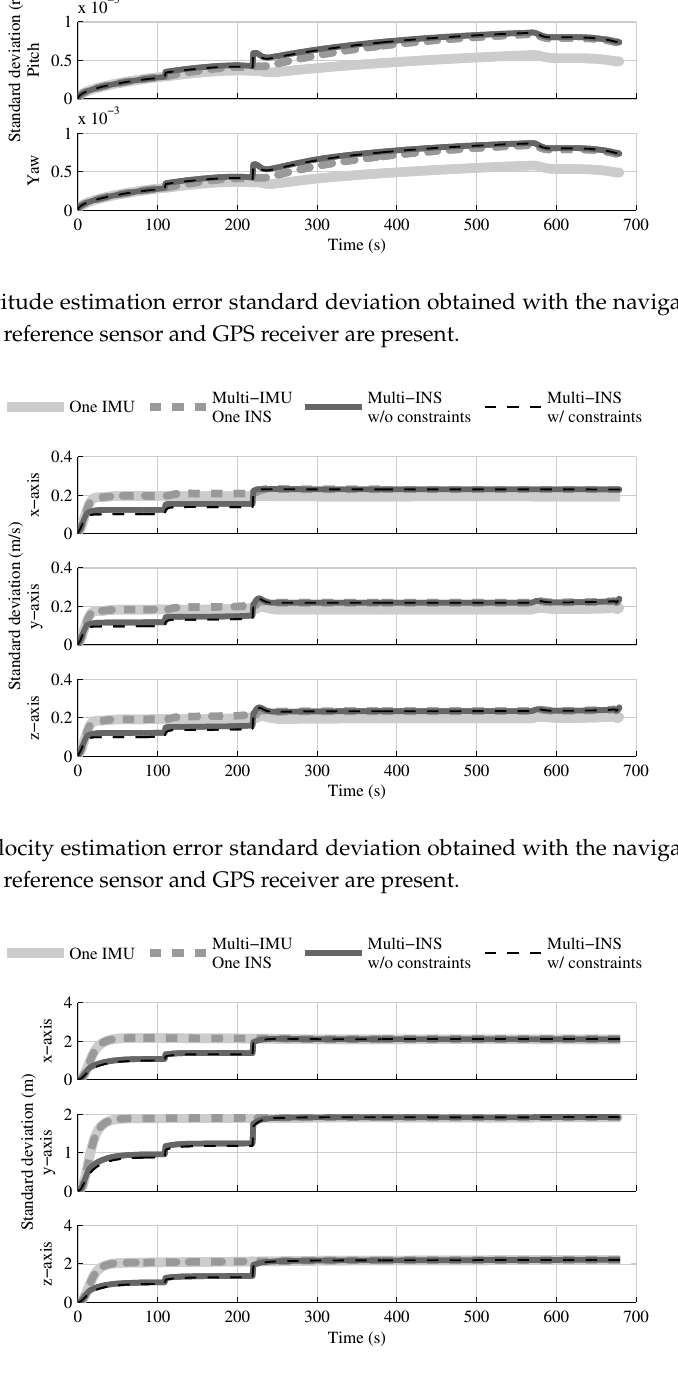
Figure 21. The position estimation error standard deviation obtained with the navigation solutions, when the attitude reference sensor and GPS receiver are